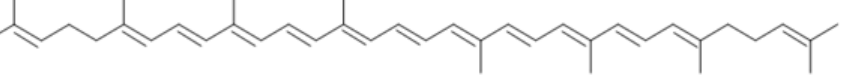
Figure 1. Chemical structure of LYC.